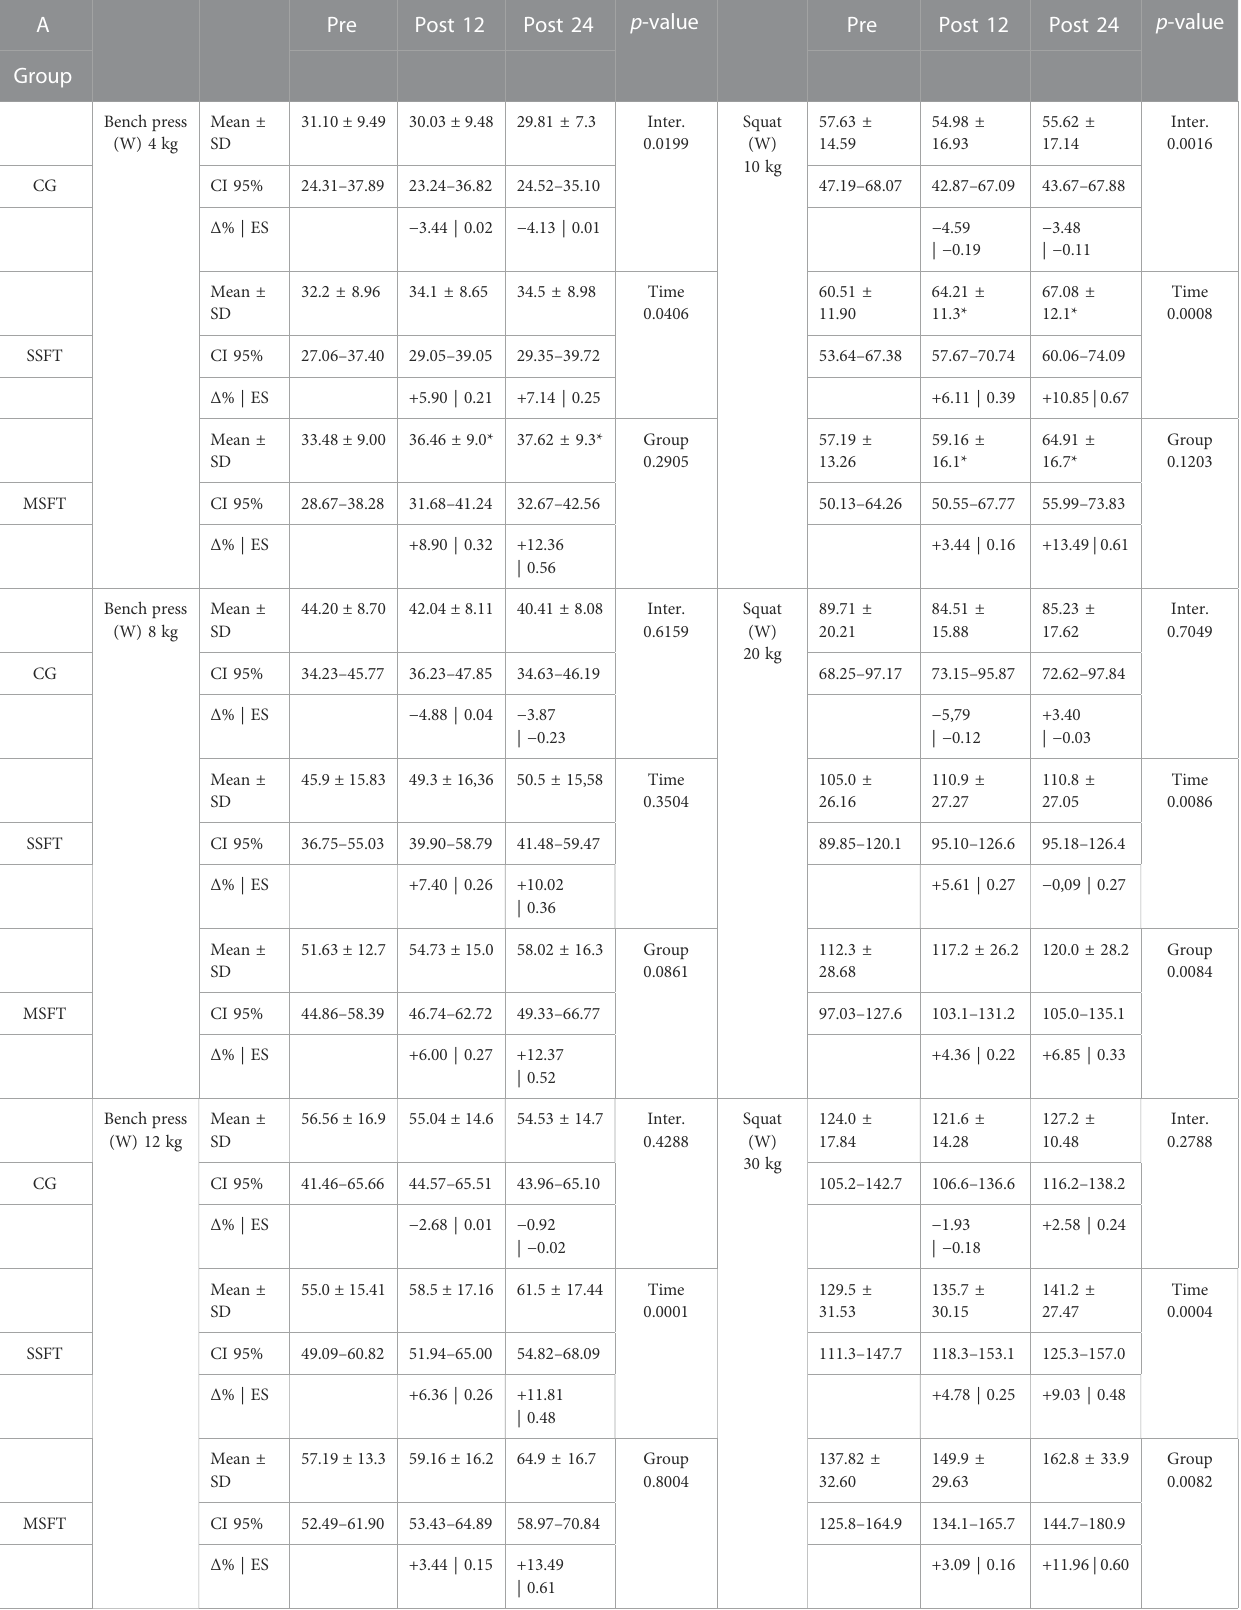
TABLE 3 Effect of Single-Set Functional Training (SSFT) and Multiple-Set Functional Training (MSFT) on upper and lower limb muscle